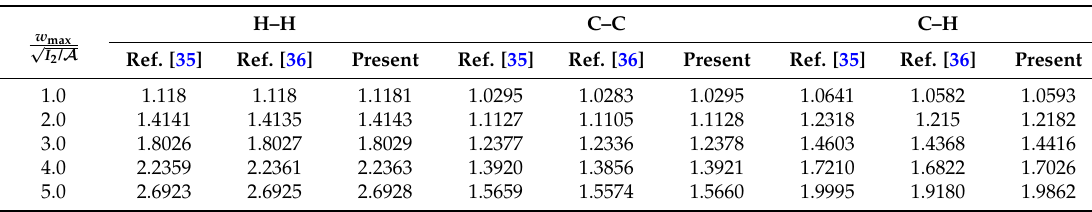
Table 1. Comparison of nonlinear frequency ratio of a Timoshenko straight beam for different vibration amplitudes.